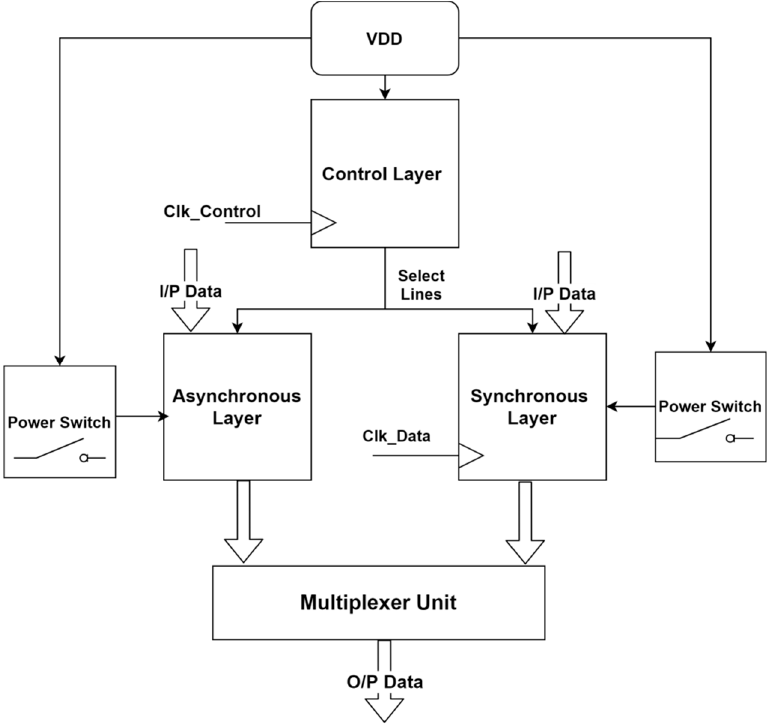
Figure 13. The proposed double-layer circuit-switched NoC with two data transfer layers and a single control layer. Power switches were added to activate or deactivate the corresponding layers.